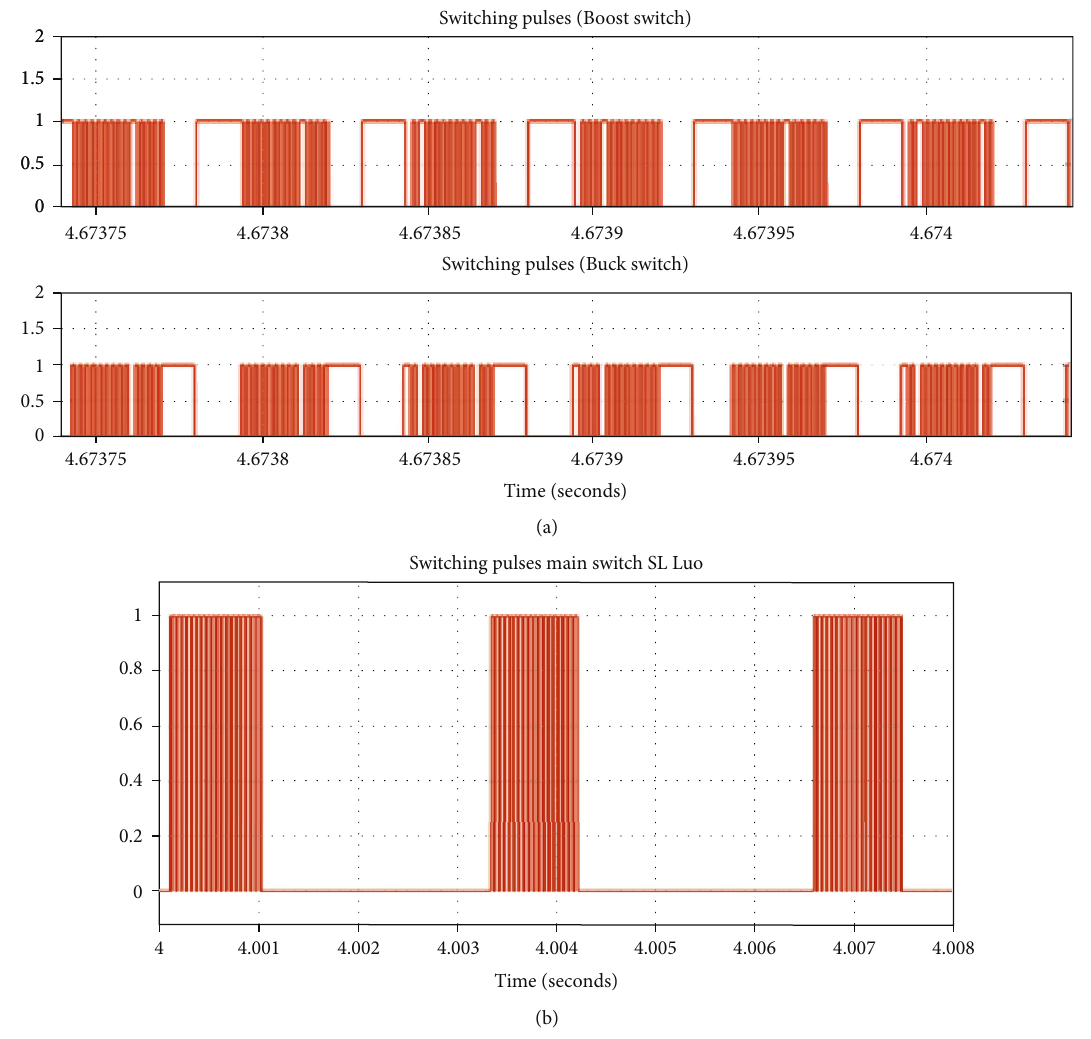
Figure 13: (a) Switching pulses for buck boost switches. (b) Switching pulses for relift